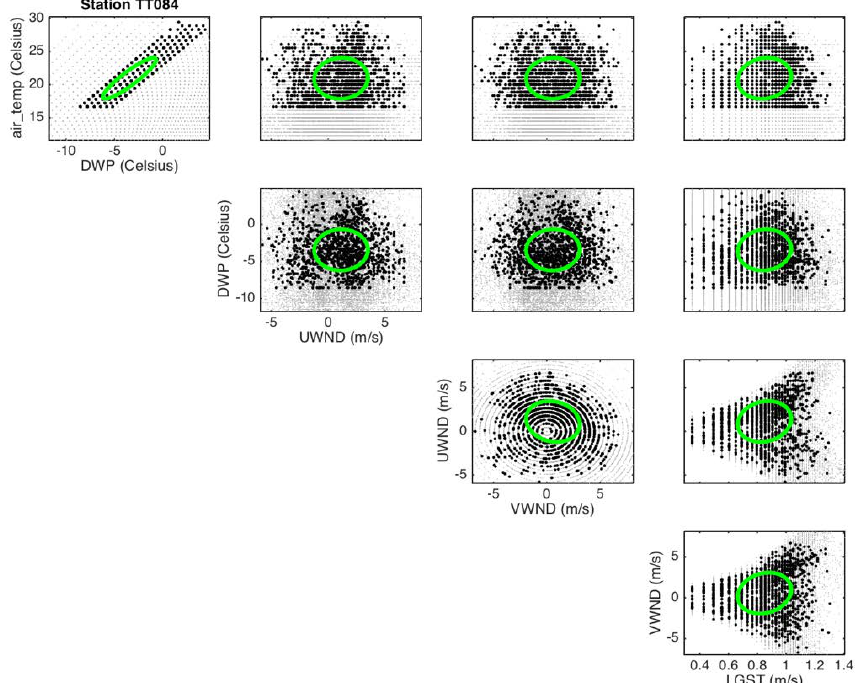
Figure A10. As in Figure 4 but for station